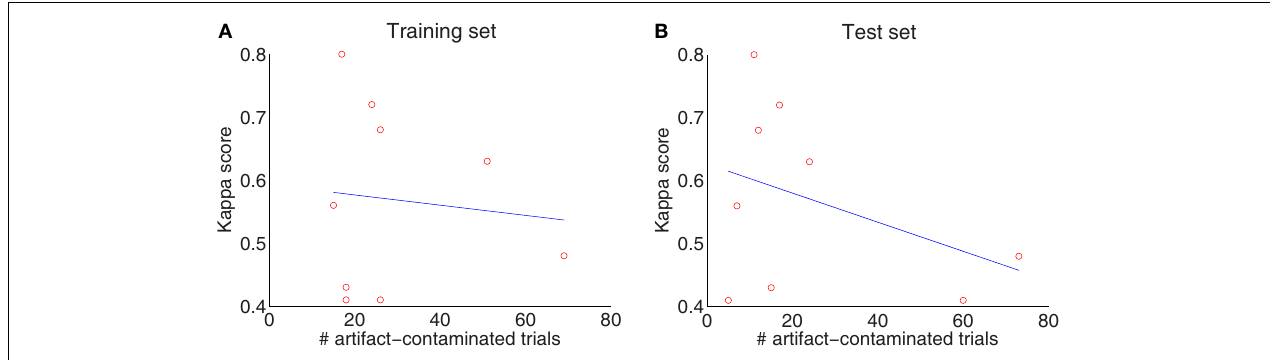
FIGURE 3 | Influence of artifacts: the number of artifact-contaminated trials influences the decoding of the test set (A) but not the training set (B).